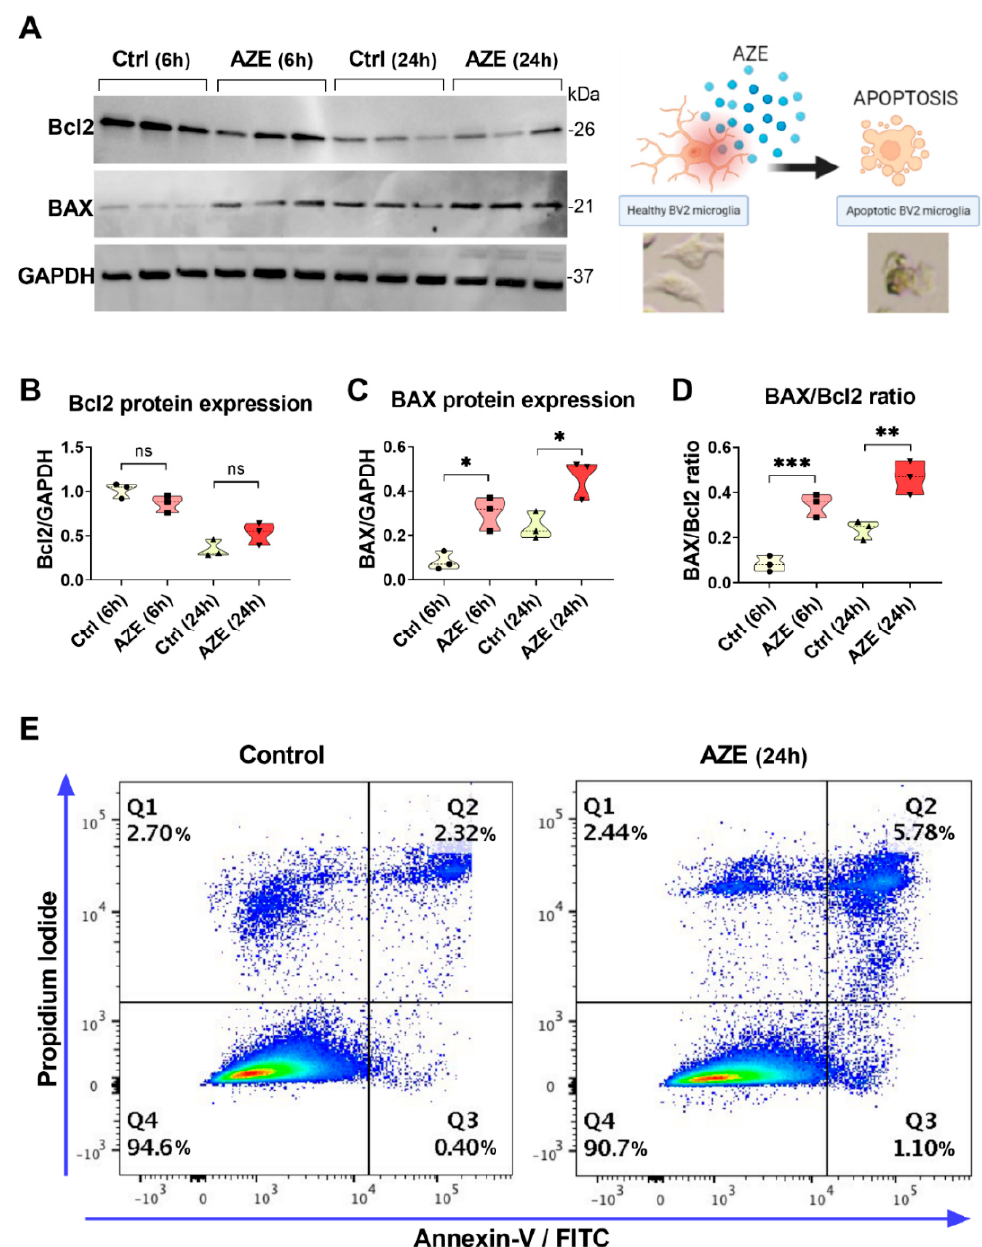
Figure 2. ( A ) Representative Western blots showing Bcl2 and BAX protein expression in BV2 cells cultured in the presence or not of AZE (1000 µM) for 6 or 24 h. GAPDH was used as loading control. ( B – D ) Violin plots depicting results from densitometric analyses of Bcl2 and BAX blots as well as BAX/Bcl2 ratios. Results shown are the mean ± SEM of two independent determinations, each run in triplicate. Ns = not significant. * p < 0.05, ** p < 0.01 or *** p < 0.001 vs. Ctrl at the corresponding time point, as determined by ANOVA and Sidak’s post hoc test. ( E ) The incidence of apoptotic cells was examined by flow cytometry using Annexin V-FITC/PI staining. The experiment was repeated twice with overlapping